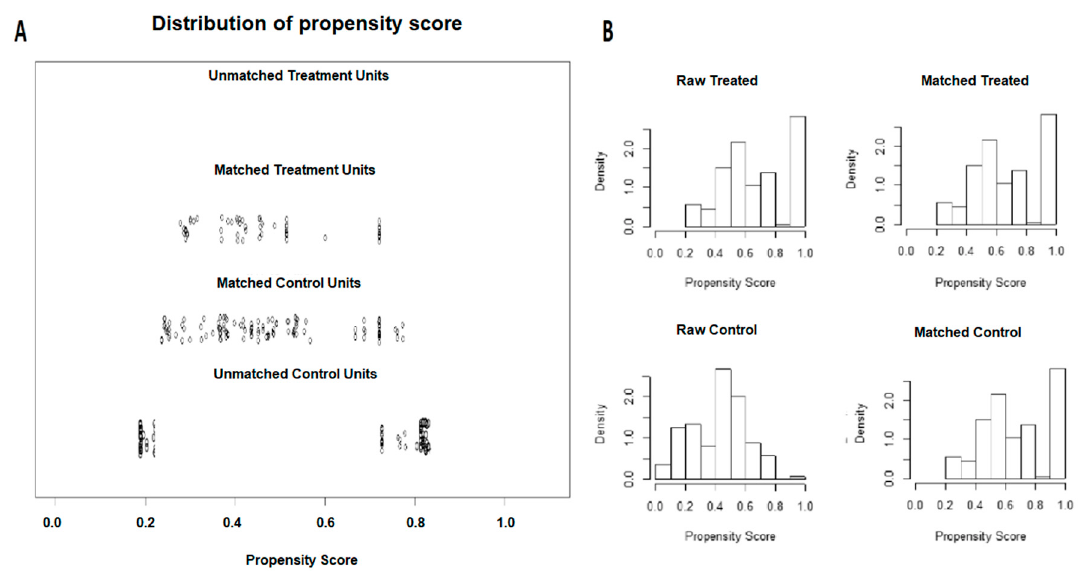
Figure 1. Propensity score matching of the two study groups. Out of the initial 175 patients, after 1-to-2 propensity score caliper matching 135 patients were included in the study: 45 treated with radioembolization plus sorafenib and 90 treated with radioembolization alone. ( A ) Propensity score matching jitter plot; ( B ) propensity score matching histogram. Table 1. Baseline characteristics of enrolled patients.